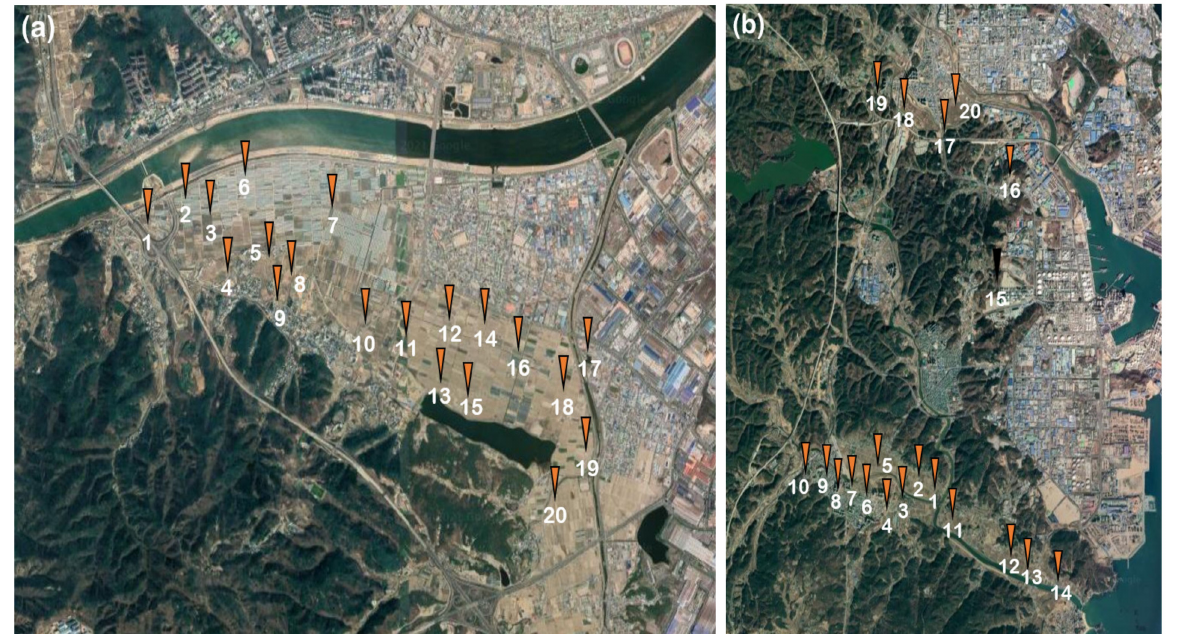
Figure 1. Sampling sites of Korean paddy soils: ( a ) 20 sites of Pohang city; ( b ) 20 sites of Ulsan